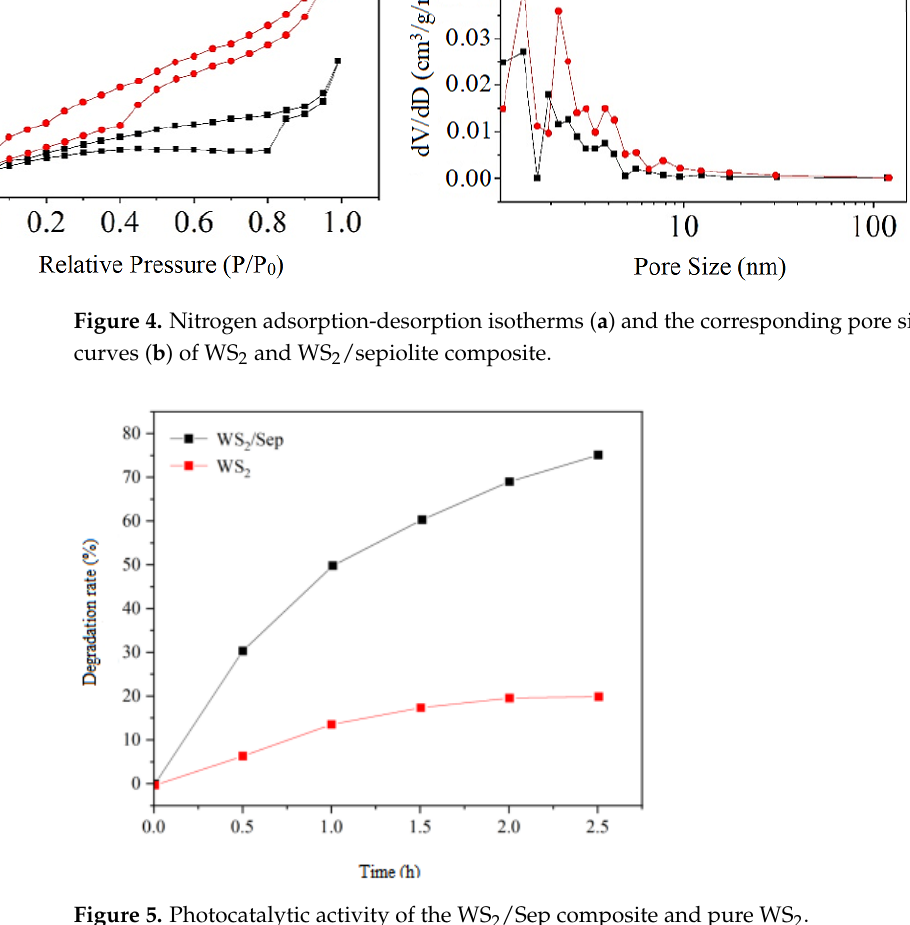
Figure 4. Nitrogen adsorption-desorption isotherms ( a ) and the corresponding pore size distribu- tion curves ( b ) of WS 2 and WS 2 /sepiolite composite.